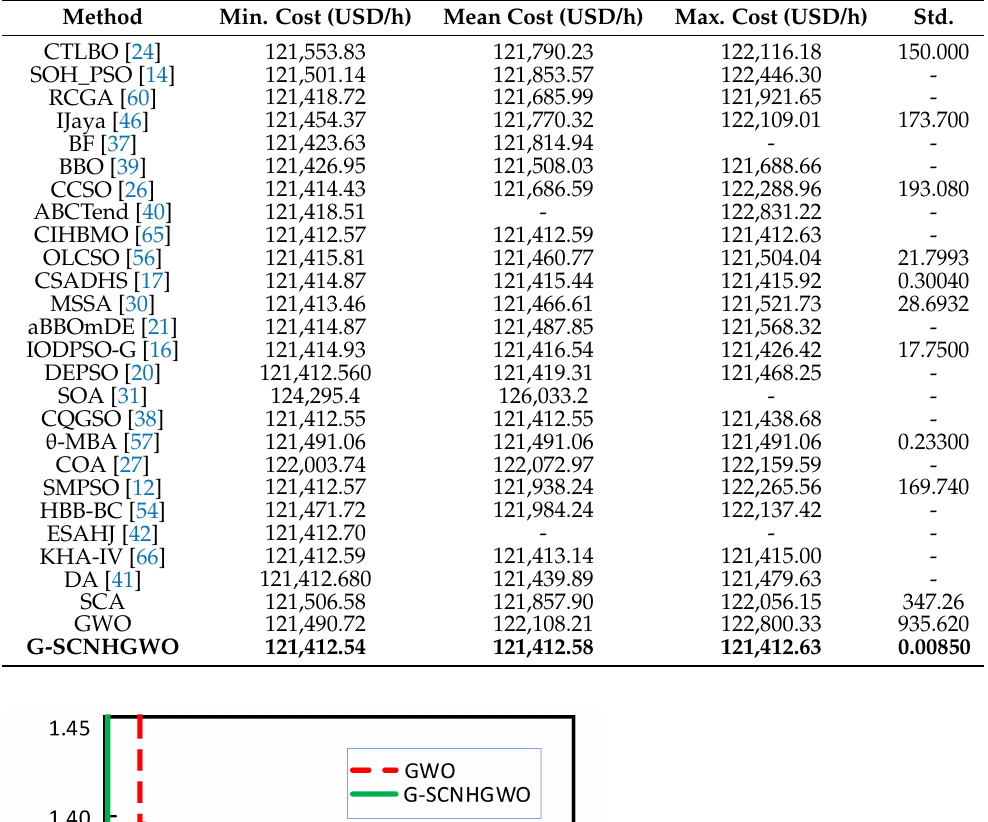
Table 10. Comparing the best results obtained by different algorithms in Case C.